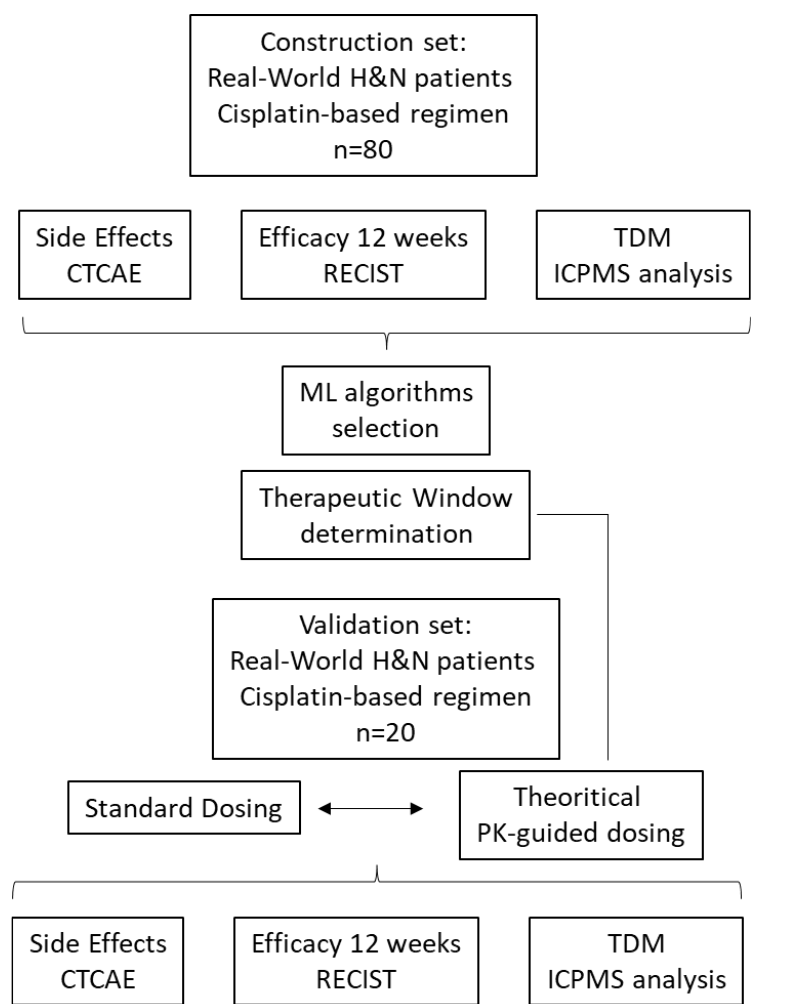
Figure 1. Workflow diagram. Data from 100 real-world patients were used (construction set: 80 pa- tients, validation set: 20 patients).